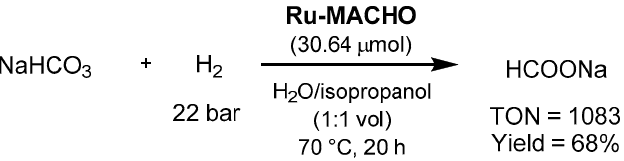
Scheme 71. Hydrogenation of sodium bicarbonate to sodium formate catalyzed by Ru-MACHO reported by Treigerman